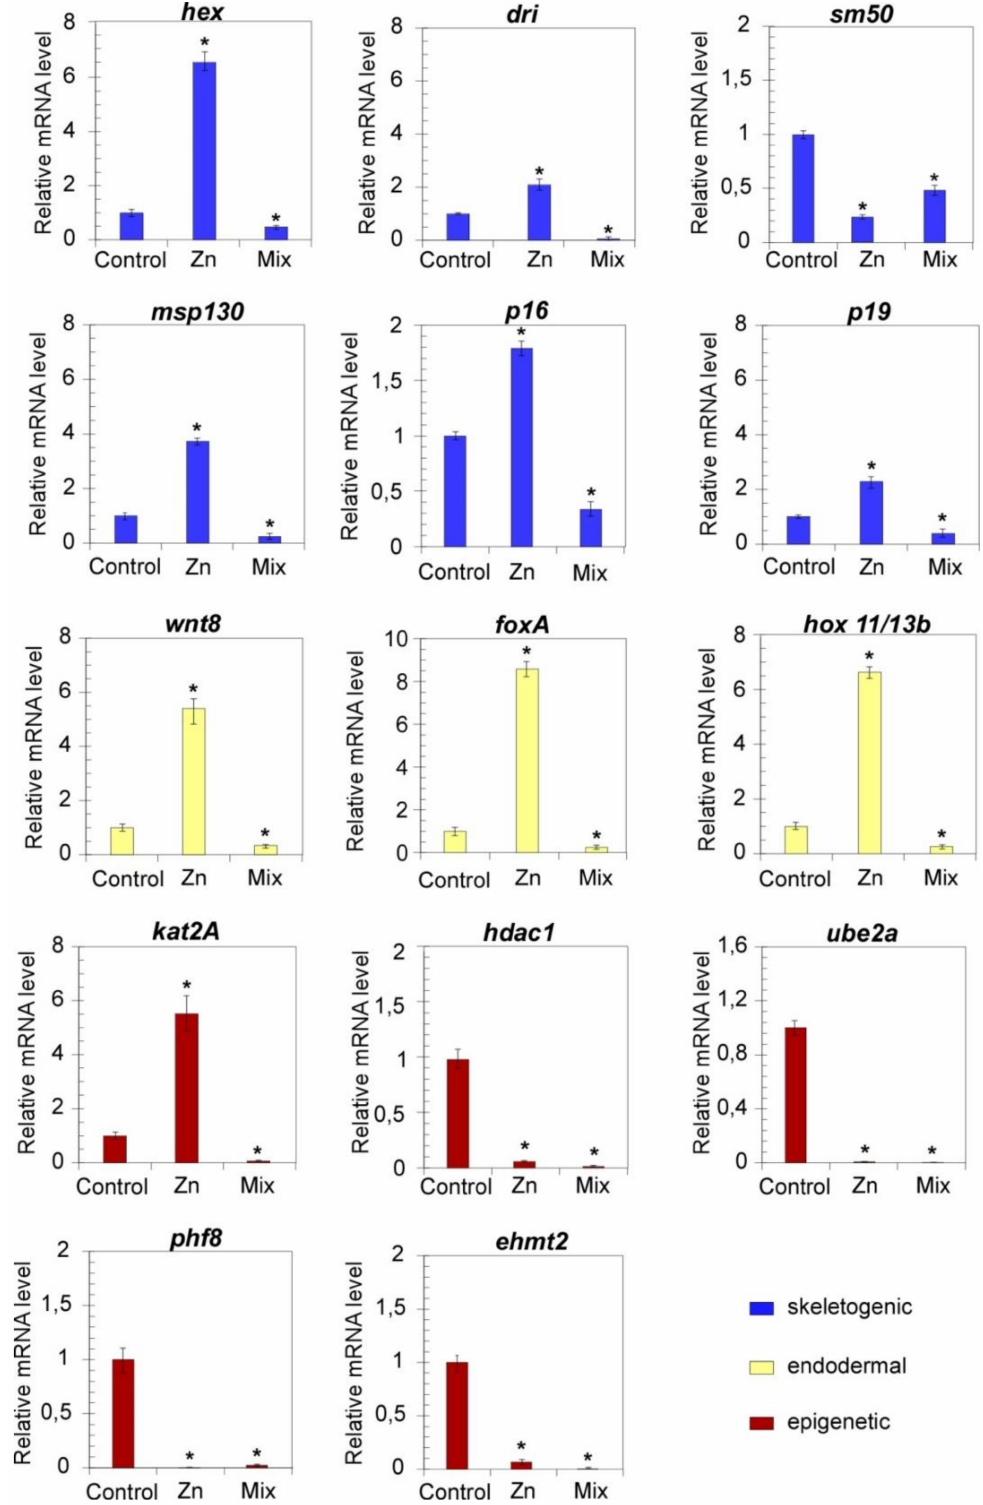
Figure 3. Parental exposures to low doses of Zn and metal mixture (as defined in Table 1) induce alterations in the mRNA expression of development and epigenetic related genes at 24 hpf. RT-qPCR results showing the mRNA levels of indicated genes in P. lividus offspring, with respect to 18S at 24 hpf. Bars represent mean ± SD. Values were considered statistically significant at p less than 0.05